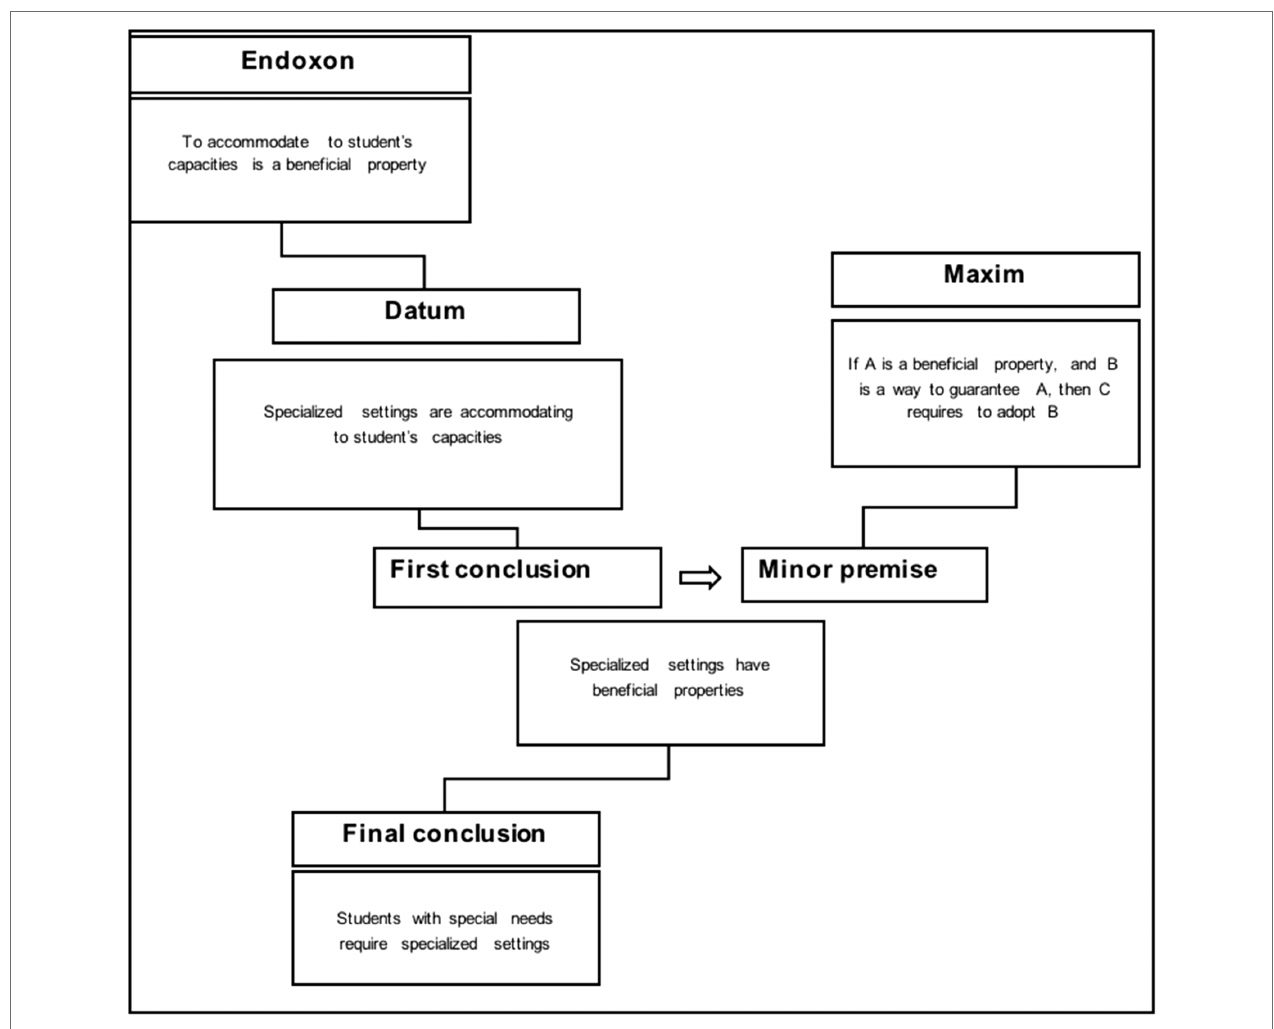
FIGURE 1 | AMT-based reconstruction of the first discourse